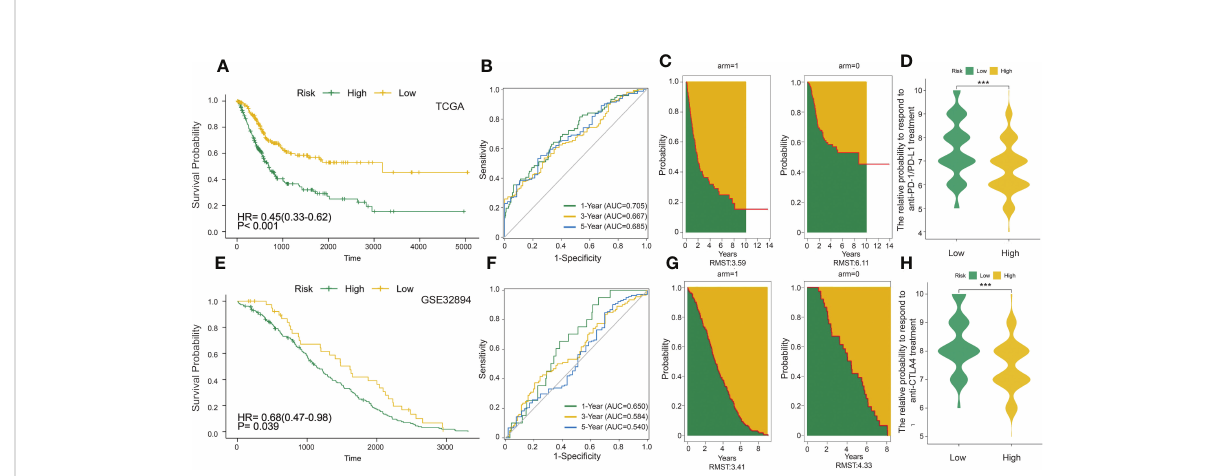
FIGURE 3 DC-related risk score was constructed in the training set and veri fi ed in the validation set. (A) Survival analysis of the DCRSL group (n = 202) and the DCRSH group (n = 202) in the training set. In these two groups, the Kaplan – Meier curve with a log-rank p-value< 0.001 showed signi fi cant survival differences. (B) Time-dependent receiver operating characteristic (ROC) curve analysis of the DCRS in the training set. The 1-, 3-, and 5- year area under curves (AUCs) were 0.705, 0.667, and 0.685, respectively. (C) The restricted mean survival (RMS) curve for the DCRS was plotted in the training set. The green part represents the RMS time, and the yellow part represents the restricted mean time lost (RMTL). (D, H) The relative probabilities of anti-cytotoxic T lymphocyte-associated protein 4 (CTLA4) and anti-programmed cell death protein 1 (PD-1)/programmed death-ligand 1 (PD-L1) treatment between the DCRSL and DCRSH groups in the training set. The asterisks indicate statistical p-values (***<0.001). (E) Survival analysis of the DCRSL (n =43) group and the DCRSH (n = 181) group in the validation set. In these two groups, the Kaplan – Meier curve with a log-rank p-value of 0.039 showed signi fi cant survival differences. (F) Time-dependent ROC curve analysis of the immune score in the validation set. The 1-, 3-, and 5-year AUCs were 0.650, 0.584, and 0.540, respectively. (G) The RMS curve for immune scores was plotted in the validation set. The green part represents the RMS time, and the yellow part represents the restricted mean time lost